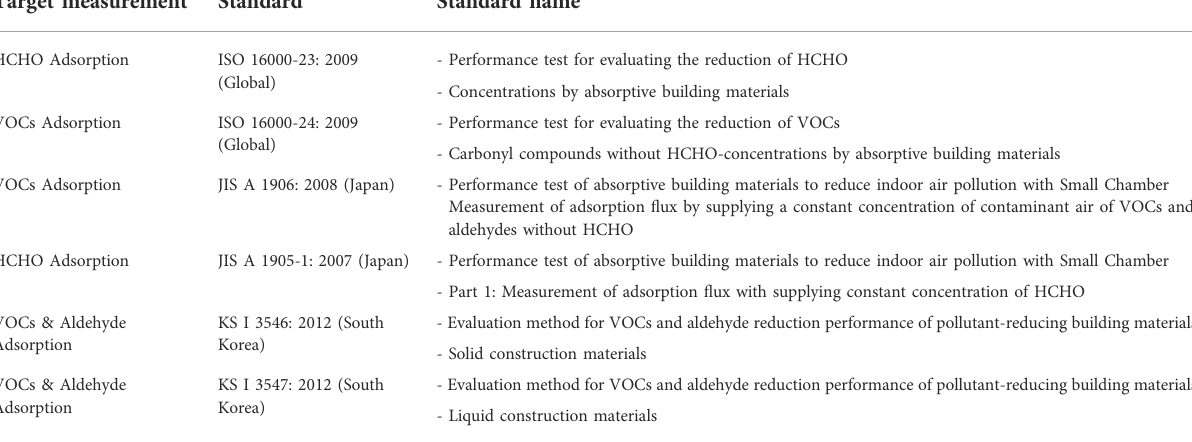
TABLE 2 Global Speci fi cations related to performance evaluation of building